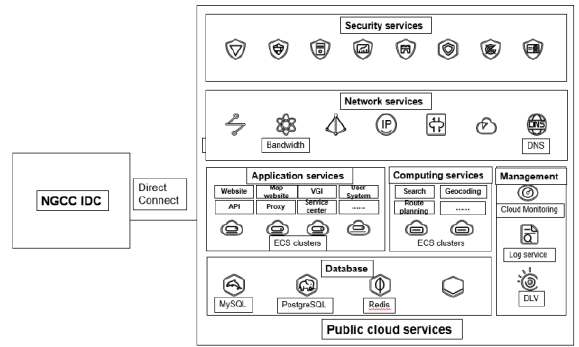
Figure3. Overall architecture of National Platform for Geospatial Information Services